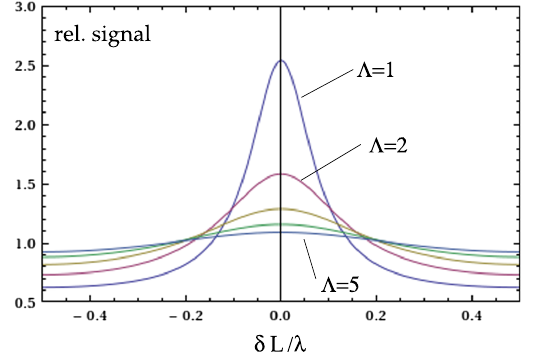
FIG. 3. Resonant-fluorescent response in a scan of the cavity length L over one x-ray wavelength λ for values of Λ ¼ 1 ; 2 ; 5 (introduced in Sec. III B). The signal is relative to the case without cavity modulation of the spectrum.